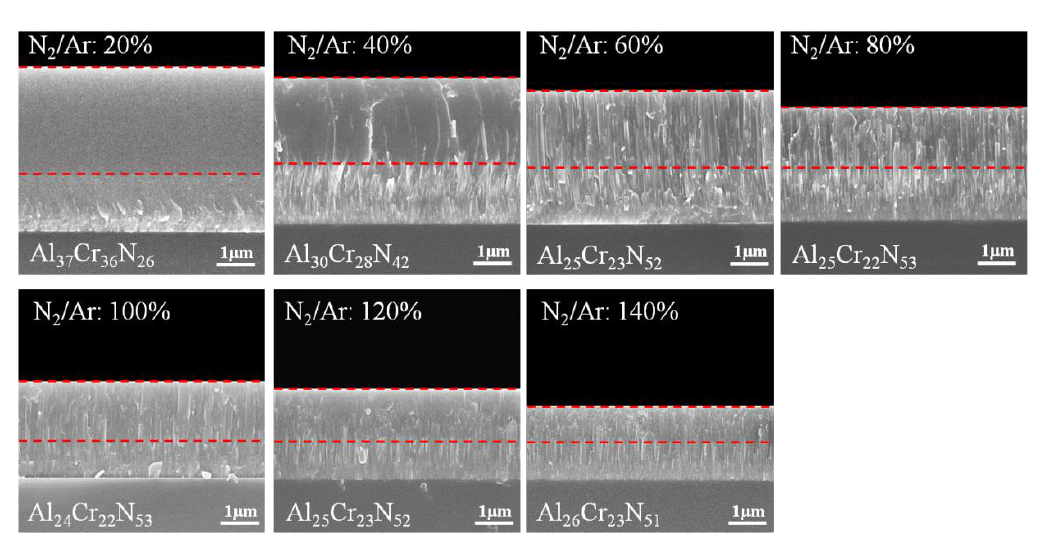
Table 3. Mechanical properties of CrAlN coatings under various N 2 / Ar flow